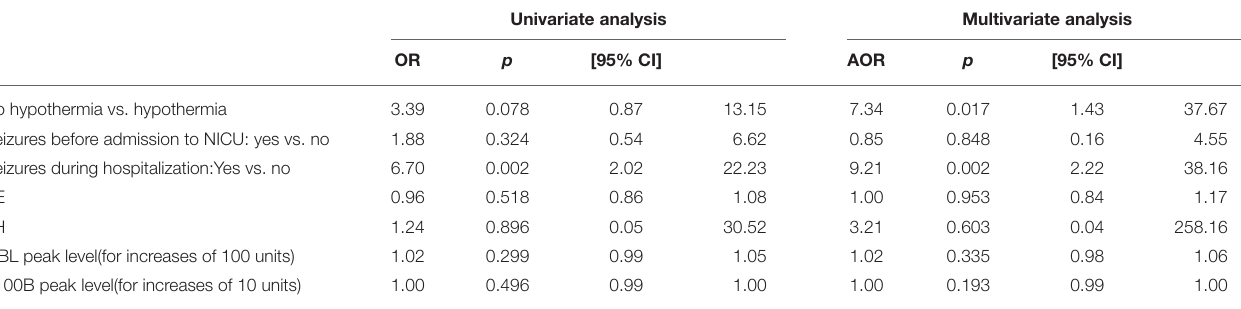
TABLE 3 | Risk of worse MRI at 7–10 days of life (3/4 vs. 1/0–2 of Barkovich score) by ordinal logistic regression analysis. Univariate